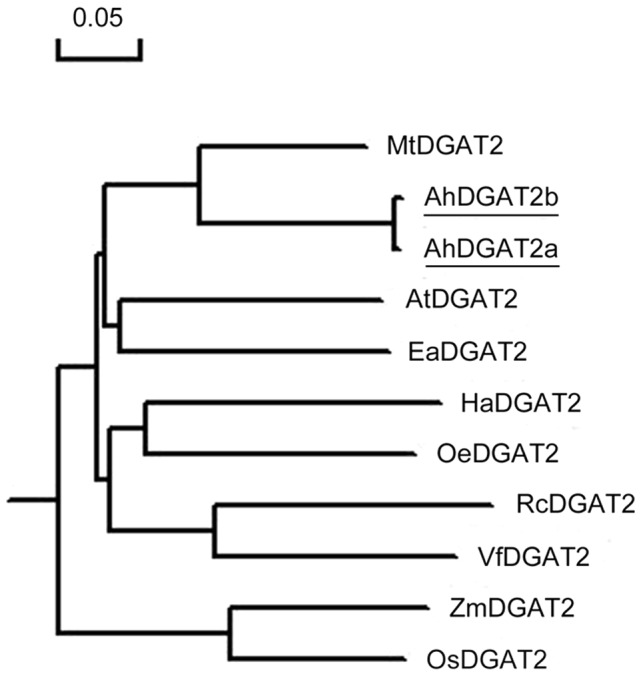
Phylogenetic tree showing relationships among the DGAT2 protein sequences from various plant species.The tree was generated using DNAMAN software. Branch lengths indicate evolutionary distance. The GenBank protein ID numbers for the DGAT2s are as follows: MtDGAT2, Medicago truncatula, ACJ84867.1; AtDGAT2, Arabidopsis thaliana, NP_566952.1; EaDGAT2, Euonymus alatus, ADF57328.1; HaDGAT2, Helianthus annuus, ABU50328.1; OeDGAT2, Olea europaea, ADG22608.1; RcDGAT2, Ricinus communis, XP_002528531.1; VfDGAT2, Vernicia fordii, ABC94473.1; ZmDGAT2, Zea mays, NP_001150174.1; OsDGAT2, Oryza sativa Japonica Group, NP_001057530.1. The two peanut DGAT2s are underlined.